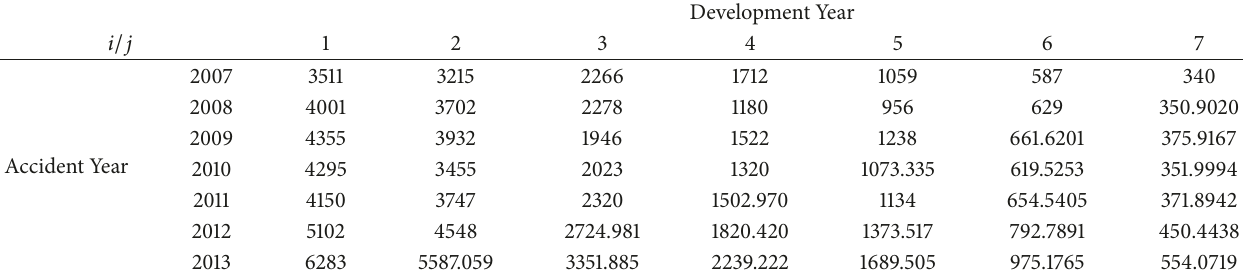
Table 7: Predicted incremental payments from run-off triangle Table